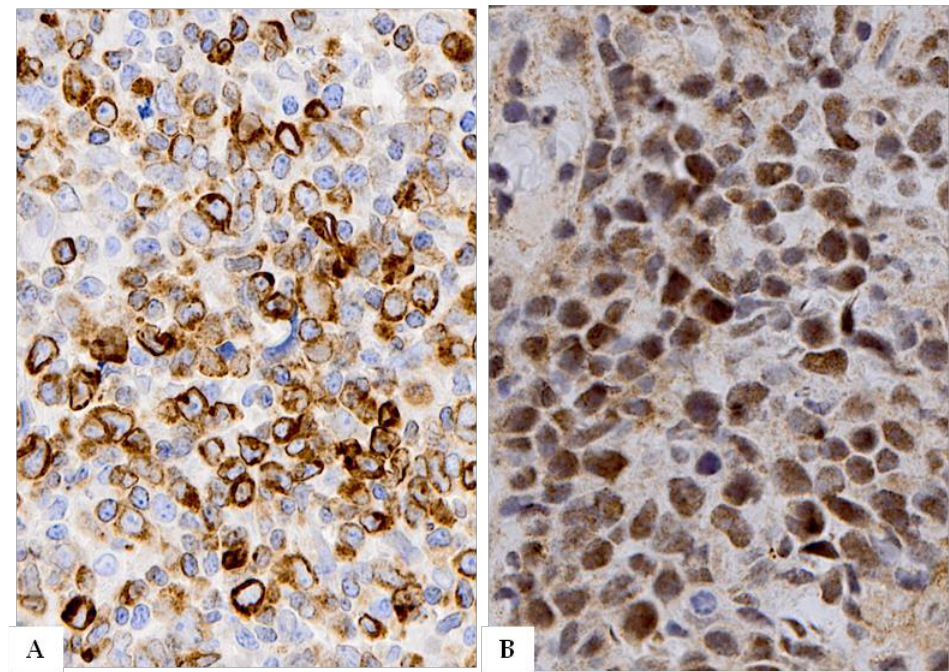
Figure 4. Diffuse large B-cell lymphoma/high-grade B-cell lymphoma with MYC and BCL2 rear- rangement. The Figure shows MYC ( A ) and BCL2 ( B ) protein expression linked to MYC and BCL2 rearrangement; 40× original magnification.